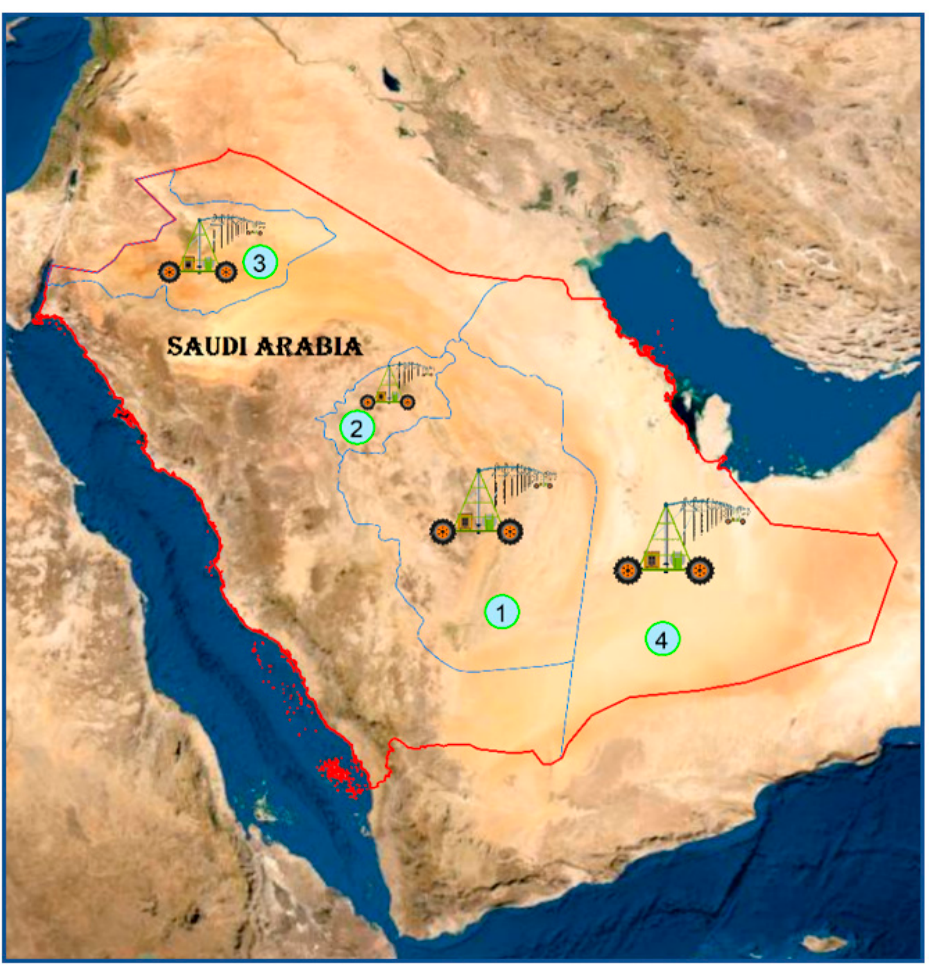
Figure 1. A map of the study sites in Saudi Arabia. (1) Riyadh, (2) Qassim, (3) Jouf, and (4) the eastern province.